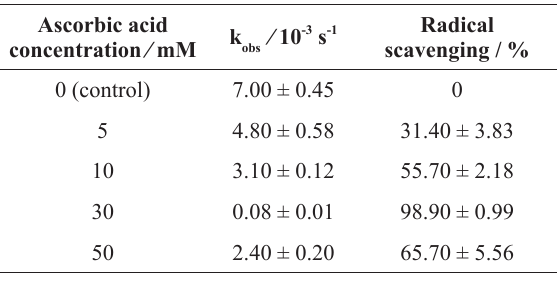
Pseudo-first order rate constant and radical scavenging capacities for different concentrations of ascorbic acid.